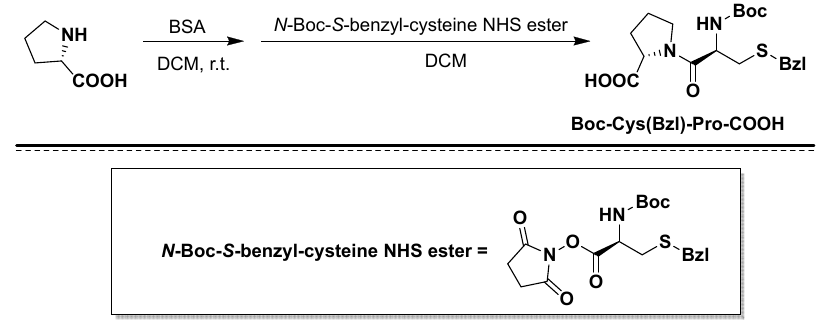
Figure 2. Synthesis of Boc-Cys(Bzl)-Pro-COOH using BSA/NHS as coupling agents.